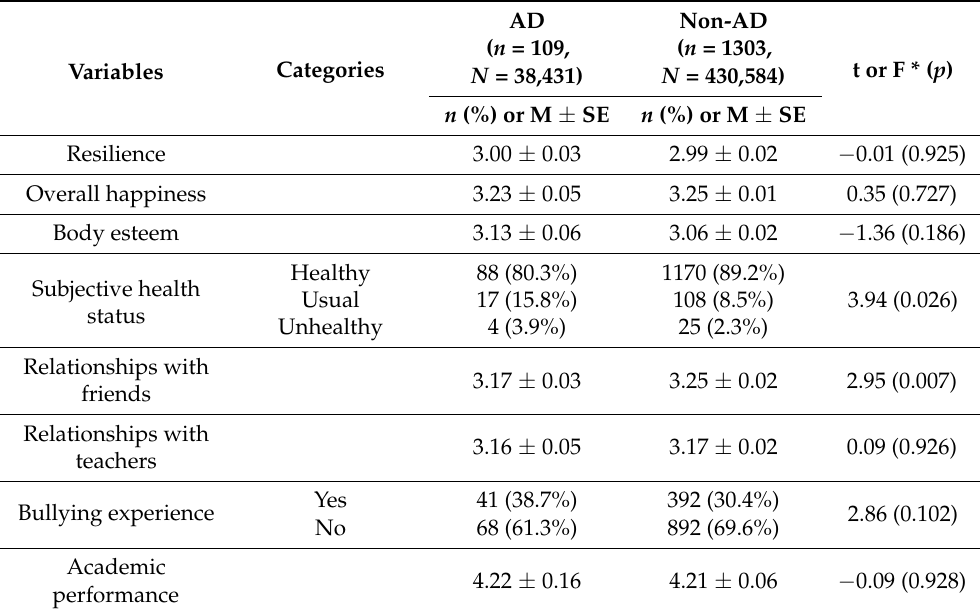
Table 3. Differences in social-emotional health by history of atopic dermatitis diagnosis ( n = 1412, N =